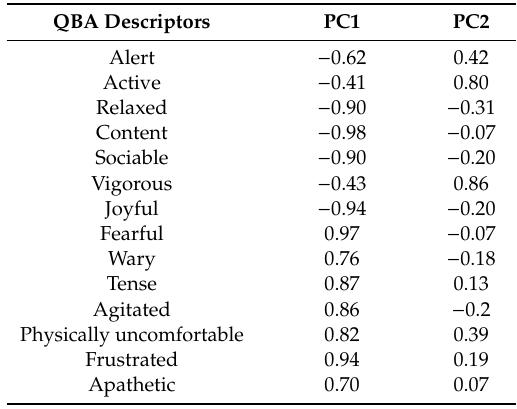
Table 5. Loadings of principal components (PC) for Qualitative Behavioral Assessment (QBA) descriptors used in to evaluate welfare of grazing sheep.